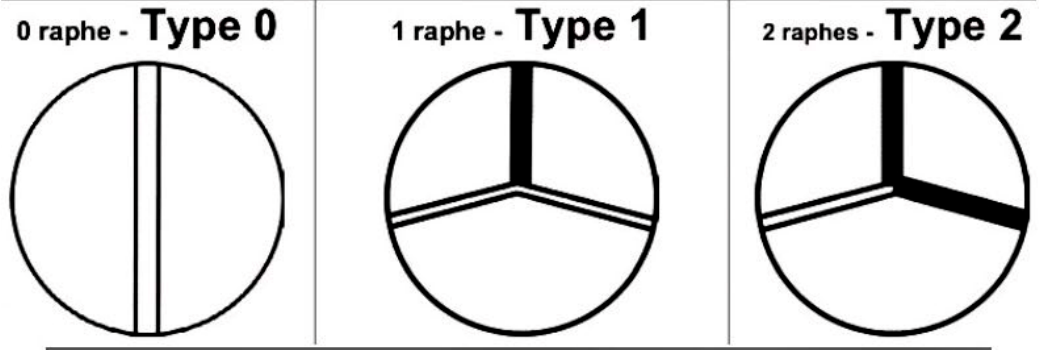
Figure 3. The Sievers classification for a BAV. The black line in schematic drawings represents a raphe, which is the nonseparated or conjoint segment of two underdeveloped cusps extending into the commissural area